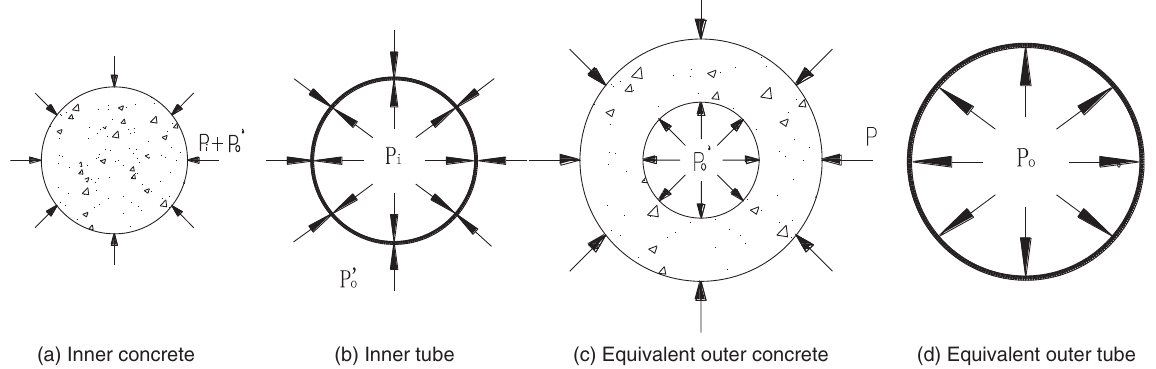
Fig. 4. Simpli fi ed model of stress of the composite column: (a) Inner concrete; (b) Inner tube; (c) Equivalent outer concrete;